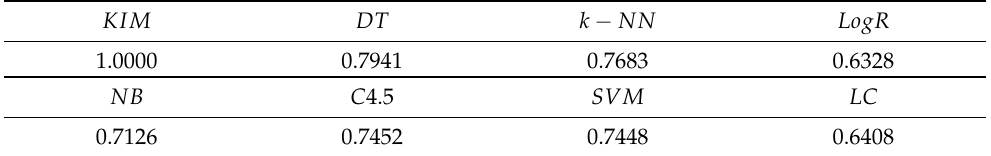
Table 4. AUC values for a dataset with a sample size of 200 with other methodologies